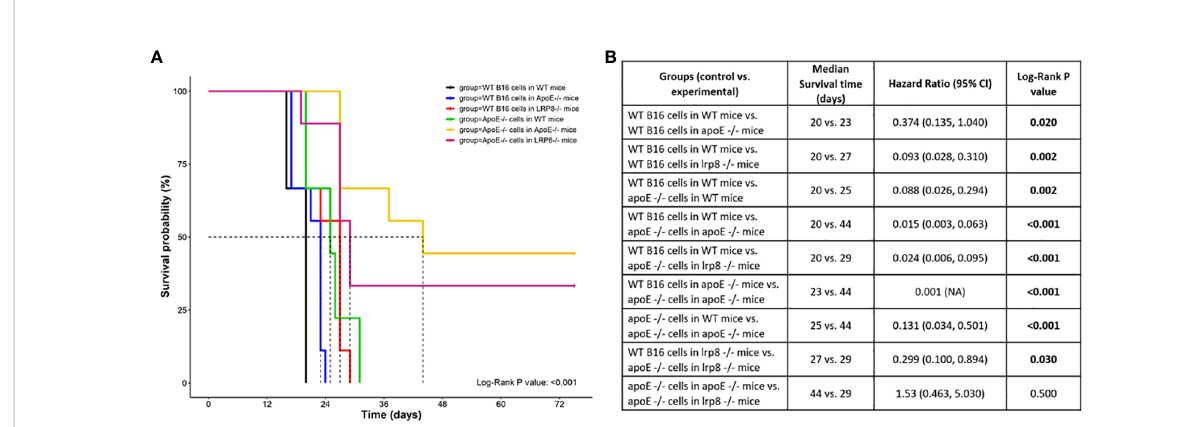
FIGURE 6 Survival curve (A) Survival was signi fi cantly better (n=9) when apoE -/- B16 cells were injected into apoE -/- or lrp8 -/- mice versus the other groups. (B) The median survival time and the cumulative survival probability were calculated and compared using the Kaplan-Meier survival estimator followed by a log-rank test, and the hazard ratio (HR) was calculated using the Cox proportional-hazards regression model. The comparison between the groups is shown in the